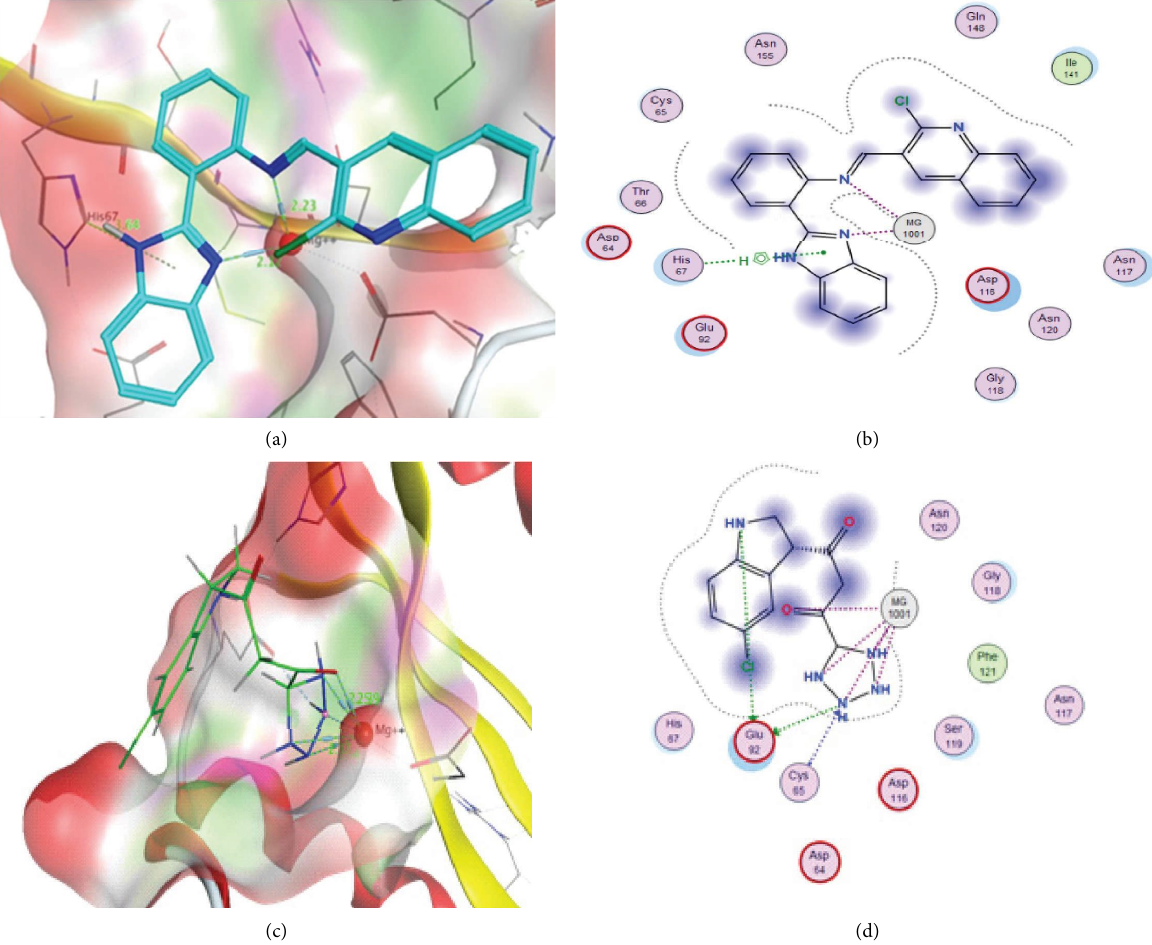
Figure 3: (a) 3D representation of the docking result of compound VII into the tunnel-like binding site of HIV-1 integrase CCD dimer. (b) 2D representation of the docking result of compound VII into the tunnel-like binding site of HIV-1 integrase CCD dimer. (c) 3D representation of the docking result of 5ClTEP into the tunnel-like binding site of HIV-1 integrase CCD dimer. (d) 2D representation of the docking result of 5ClTEP into the tunnel-like binding site of HIV-1 integrase CCD